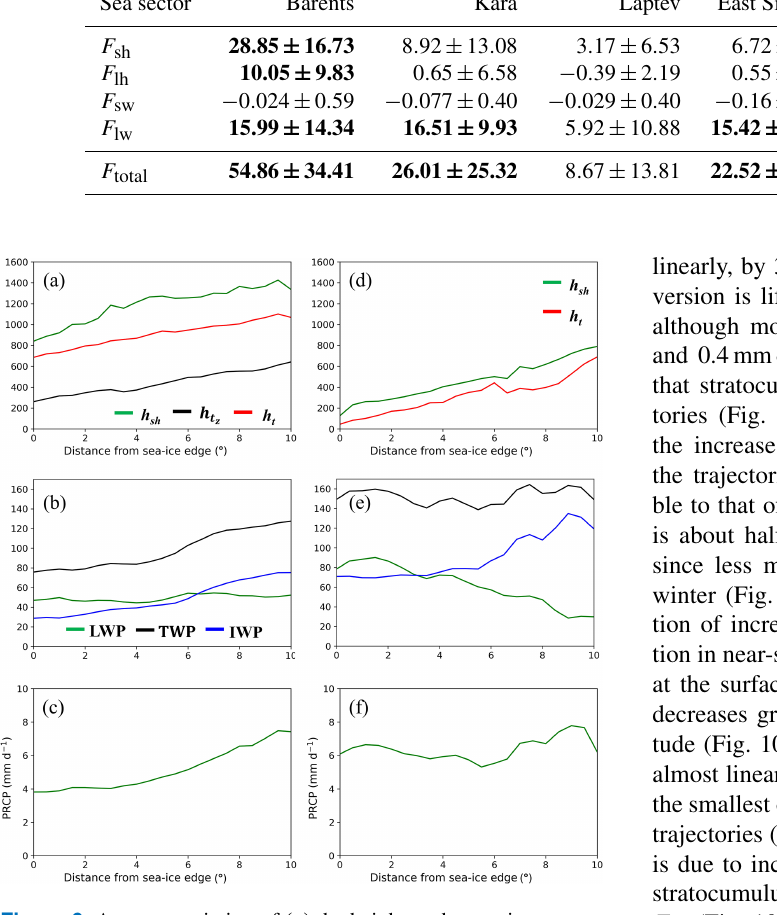
Figure 9. Average variation of (a) the height to the maximum spe- cific humidity ( h sh ), temperature gradient ( h t ; m), and tempera- z ture ( h t ); (b) liquid water path (LWP; gm − 2 ), ice water path (IWP; gm − 2 ), and total water path (TWP; gm − 2 ); (c) precipitation rate (PRCP; mmd − 1 ), with the downstream northward distance from sea-ice edge, along the WaMAI trajectories over the Barents Sea. Panels (d) , (e) , and (f) are the counterparts of panels (a) , (b) , and (c) over the frozen seas. Note that this is not necessarily the distance traveled, since WaMAIs do not need to travel due